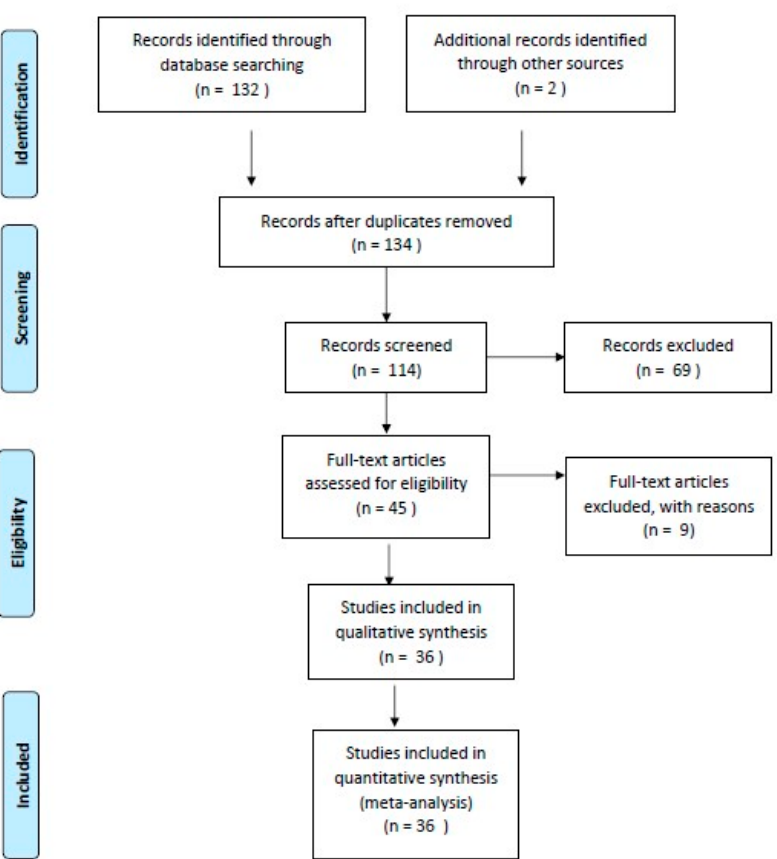
Figure 1. Selection criteria (PRISMA 2009 Flow Diagram).